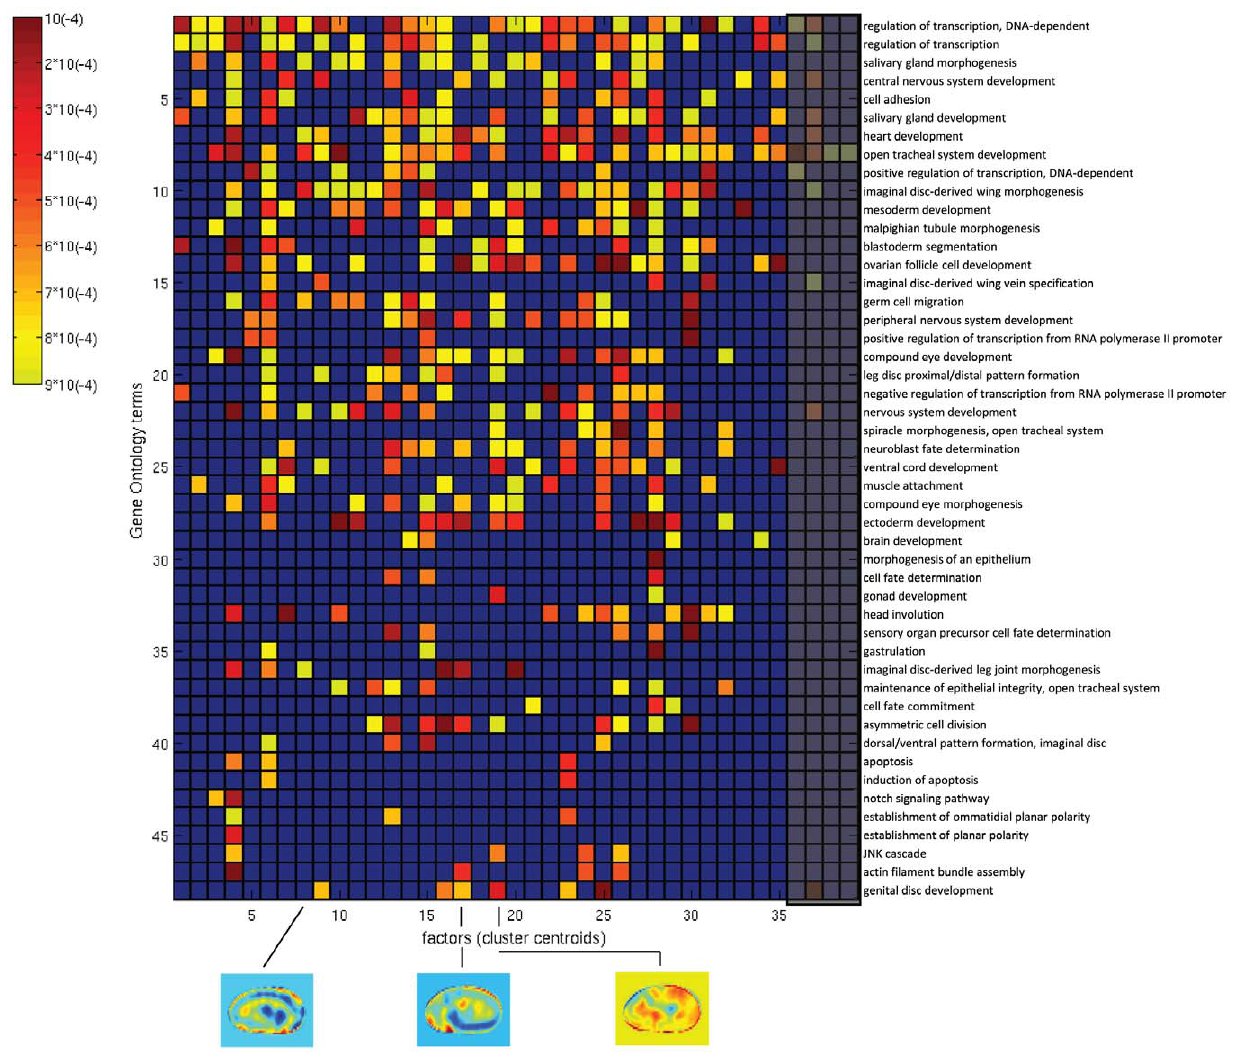
Figure 5. Enrichment of GO terms in the biological process (GO:0009987) category, for 39 representative factors (cluster centroids), developmental stages 11 – 12 . The level of significance of each GO term (vertical axis) is displayed as color intensity between yellow (p-value * 10 { 3 ) and red (p-value * 10 { 4 ), as indicated by the color bar on the left side; smaller p-values correspond to more enriched genes. The blue color corresponds to GO terms with a p-value w 0 : 001